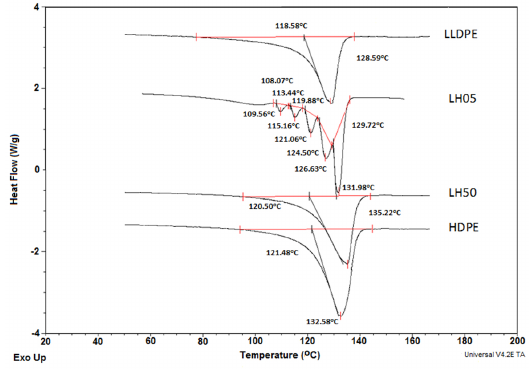
Figure 8. Hoffman-Weeks plot of LH05 blend with equilibrium melting temperature o = 124.2 °C. m T